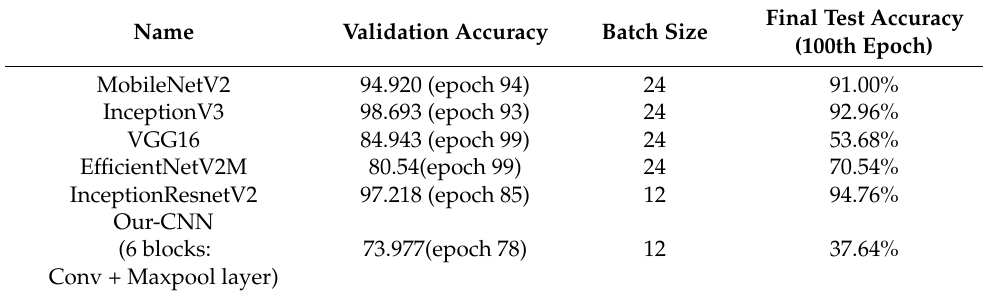
Table 2. Test and Validation accuracies for different architectures using one-step and Ima- genet